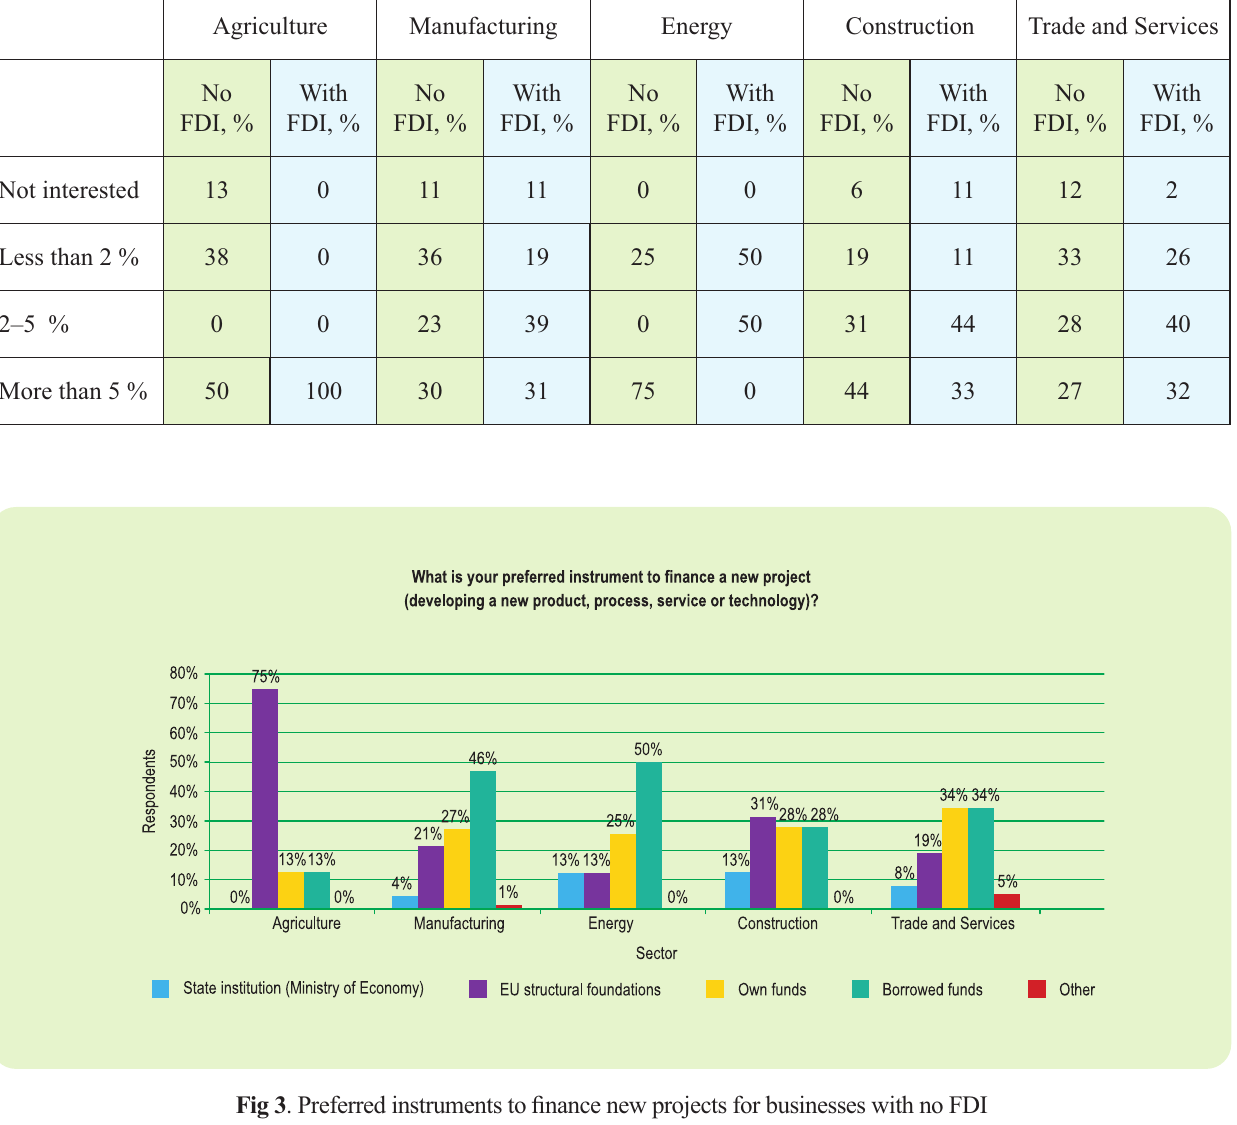
Fig 3 . Preferred instruments to fi nance new projects for businesses with no